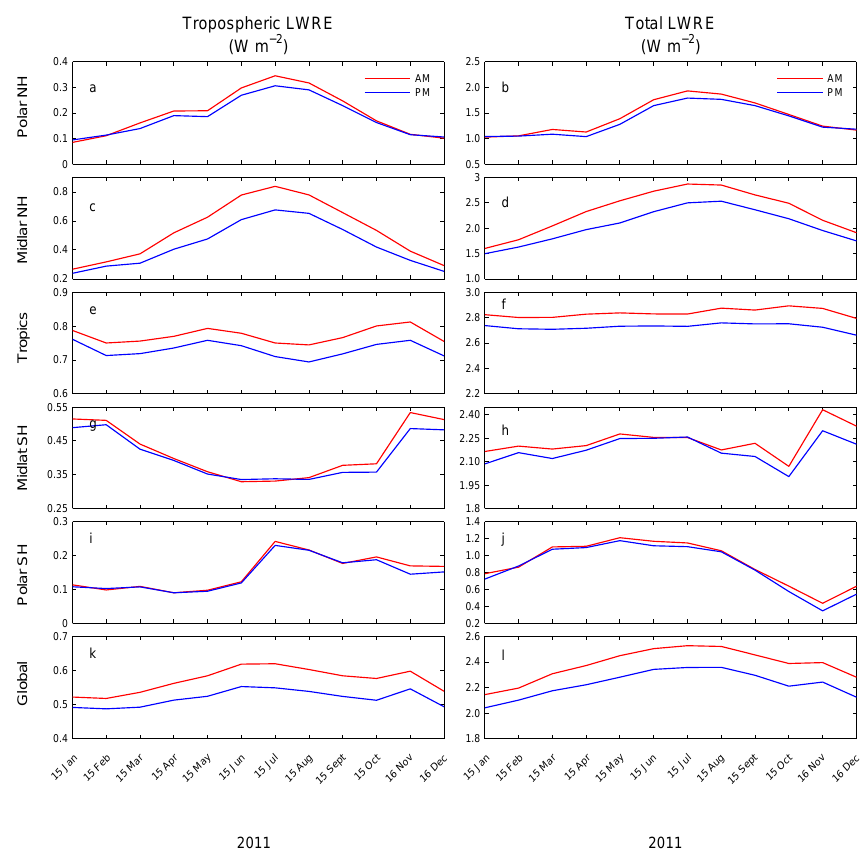
Figure 6. Zonal and global seasonal variation of (left) tropospheric O 3 LWRE and (right) total O 3 LWRE in Wm − 2 for the year 2011. Panels (a, b) and (c, d) refer to Northern Hemisphere polar and midlatitude regions, respectively; panels (e) and (f) represent the tropics; panels (g, h) and (i, j) refer to SH midlatitudes and polar regions, respectively. Panels (k, l) refer to global